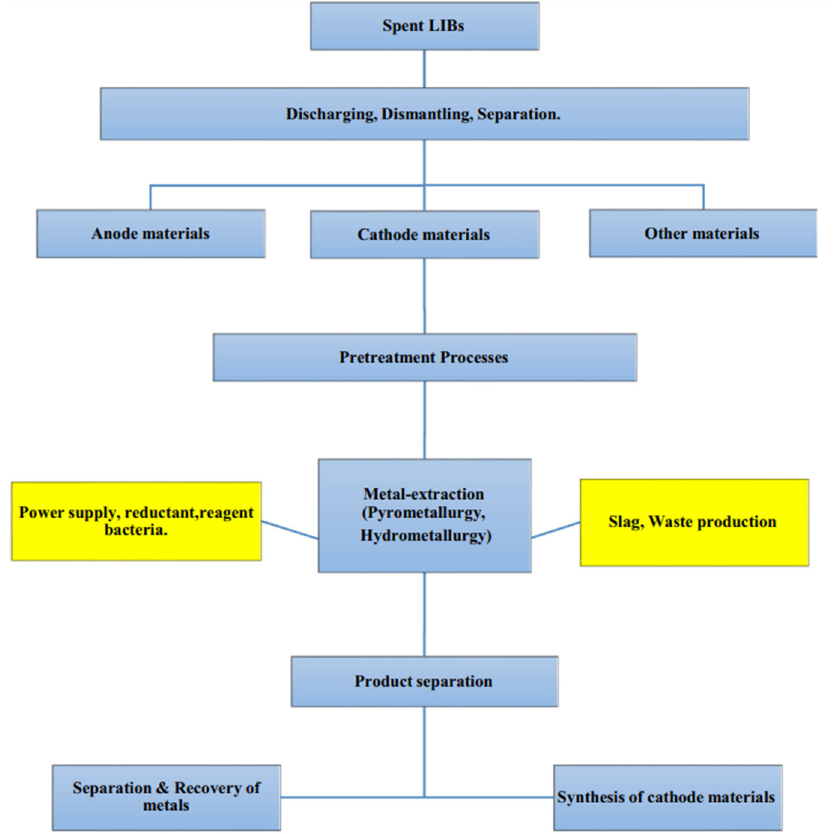
Figure 4. Classical recycling process for spent lithium-ion batteries [9].